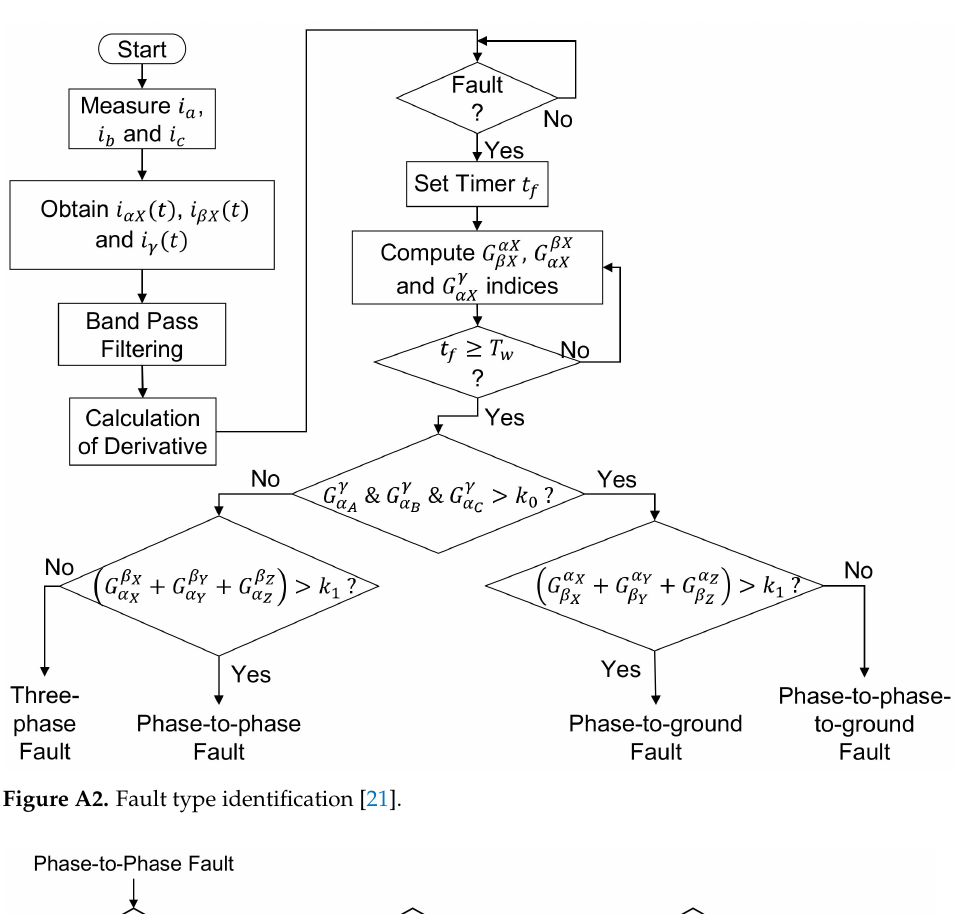
Figure A2. Fault type identification [21].